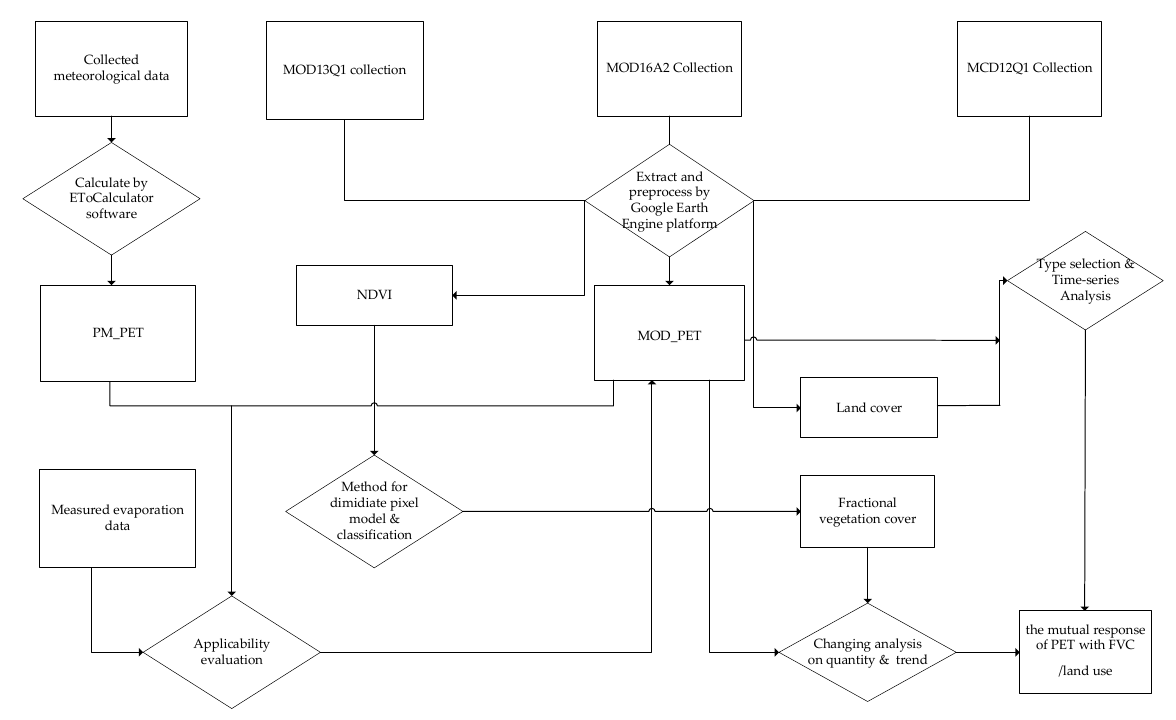
Figure 2. Flowchart of the methods employed in this